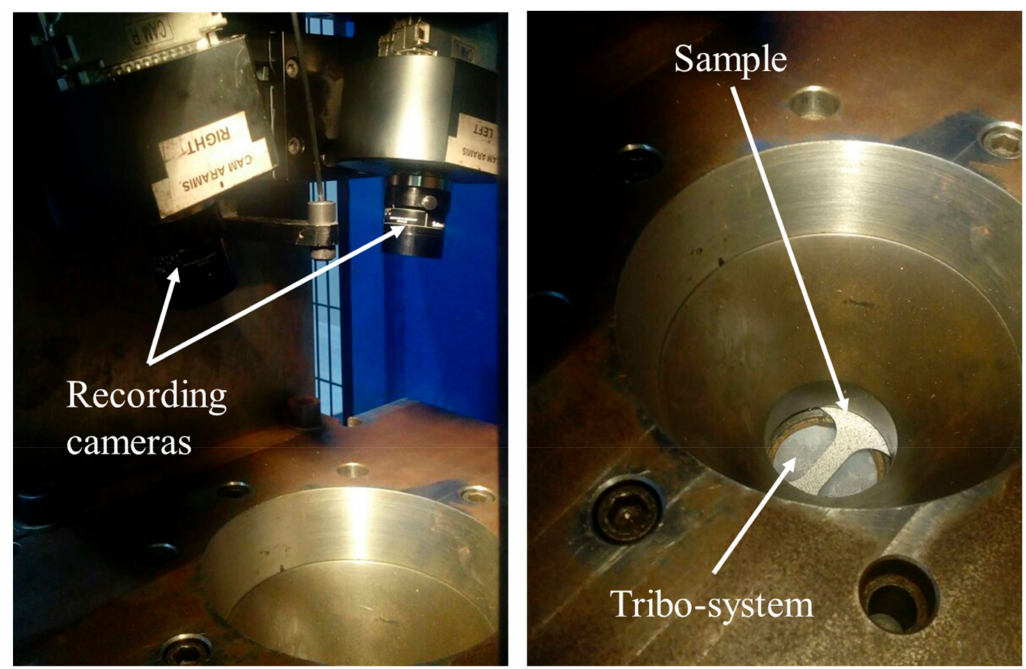
Figure 3. Setup for the Nakajima test with two recording cameras, the sample and the